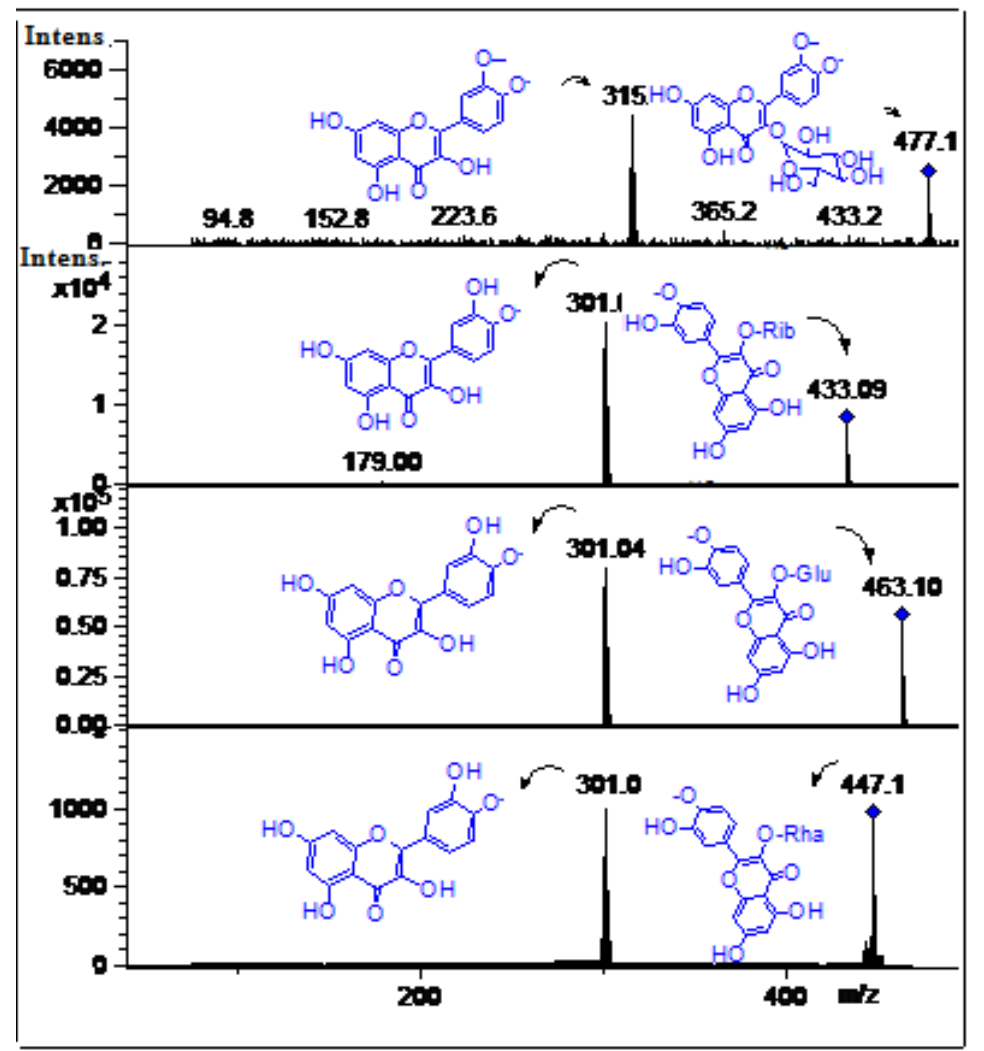
Figure 9. Structures, fragmentation, full ESI-MS and MS-MS spectra of peaks 16 , 17 , 18 and 19